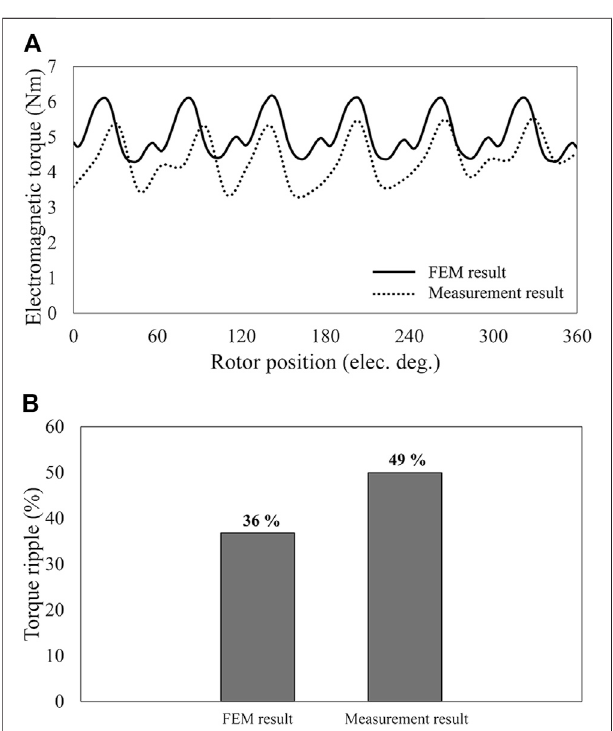
FIGURE 12 | The FEM and measurement result of (A) electromagnetic torque and (B) ripple torque at the load current of 2 A of the proposed 18/15- poles DSPM (400 rpm rotating